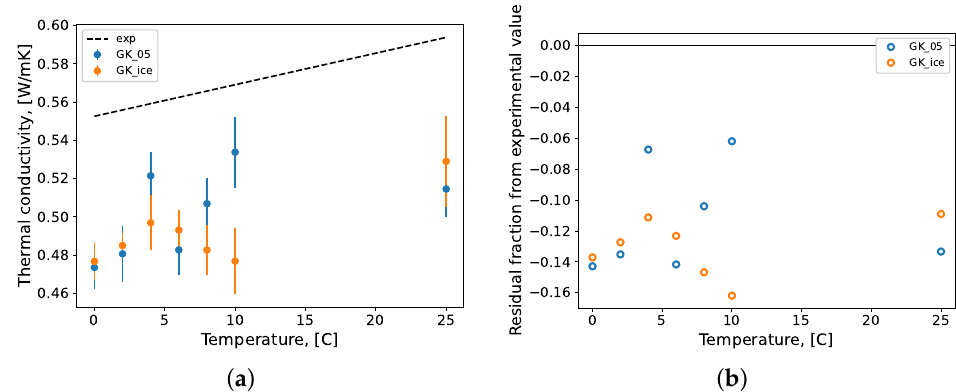
Figure 7. The ( a ) thermal conductivity of pure water systems and ( b ) fractional residual difference between MD prediction and experimental values. Repeated simulation produced samples of each condition’s prediction value of size n = 10; these samples were bootstrapped with replacement ( n = 10,000) to calculate the mean values which are presented here with their standard error bars. GK: Green–Kubo formulation; 05: TIP4P/2005; ice: TIP4P/Ice; exp: linear regression of experimen- tal data [104,105].